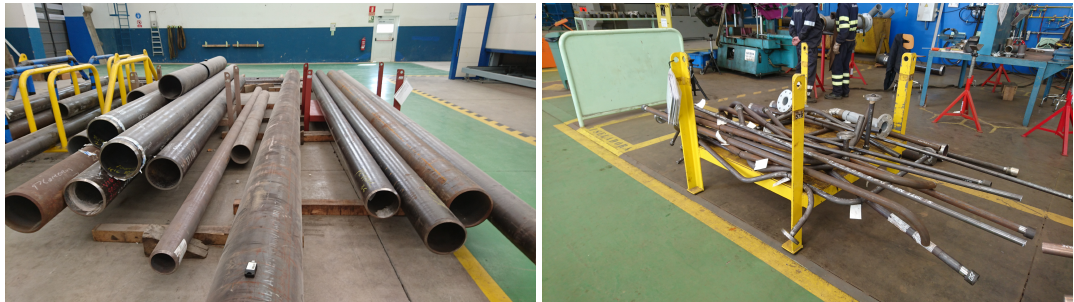
Figure 3. Reception area ( left ) and pipes stacked on a pallet after cutting ( right ).